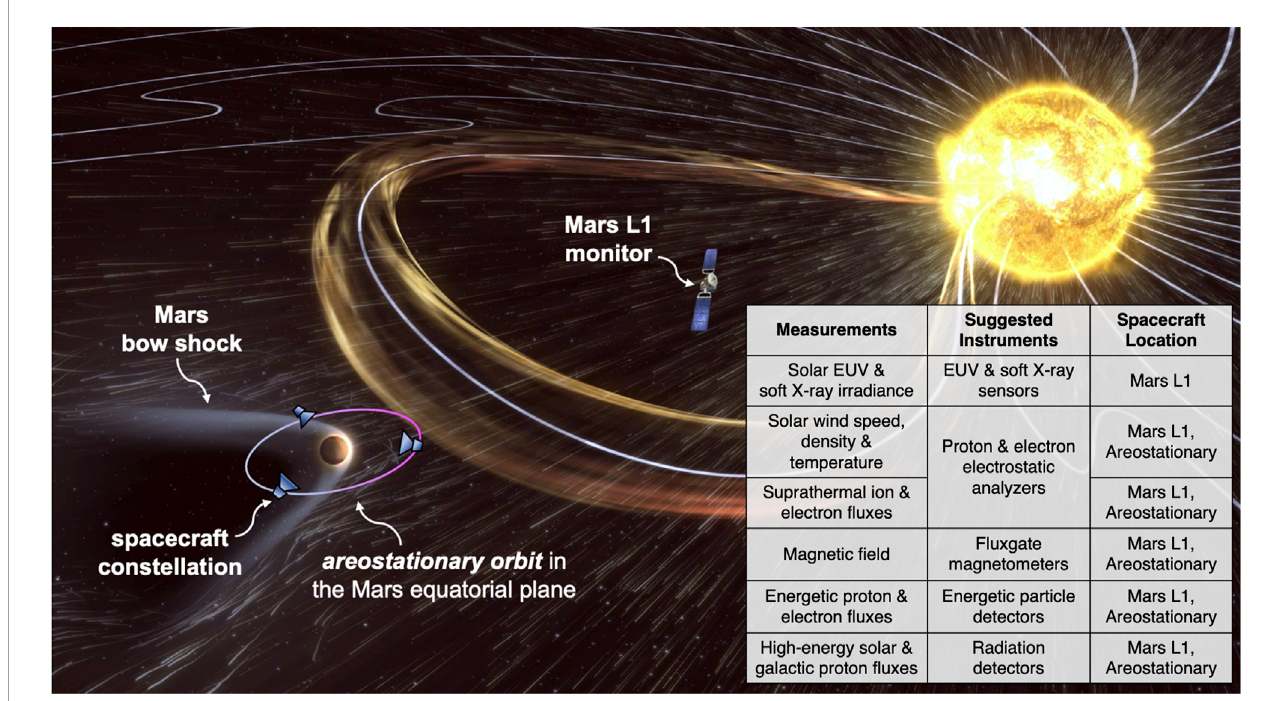
FIGURE 2 Concept (not shown to scale) of monitors at Mars L1 (upstream at ∼ 1.1 million km) and in areostationary orbit (the Mars-equivalent of geostationary orbit; ∼ 17,000 km altitude) situated in the Mars equatorial plane during a Mars-directed ICME event. A suggestion for instruments and their measurements along with the observation location is listed in the table. The image is adapted from